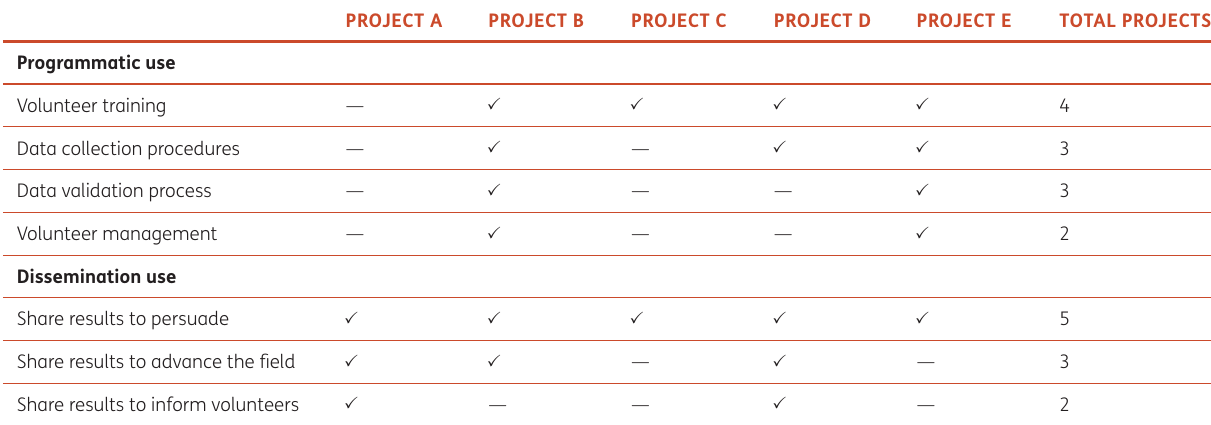
Table 5 Ways that results were used to inform CS project implementation and the